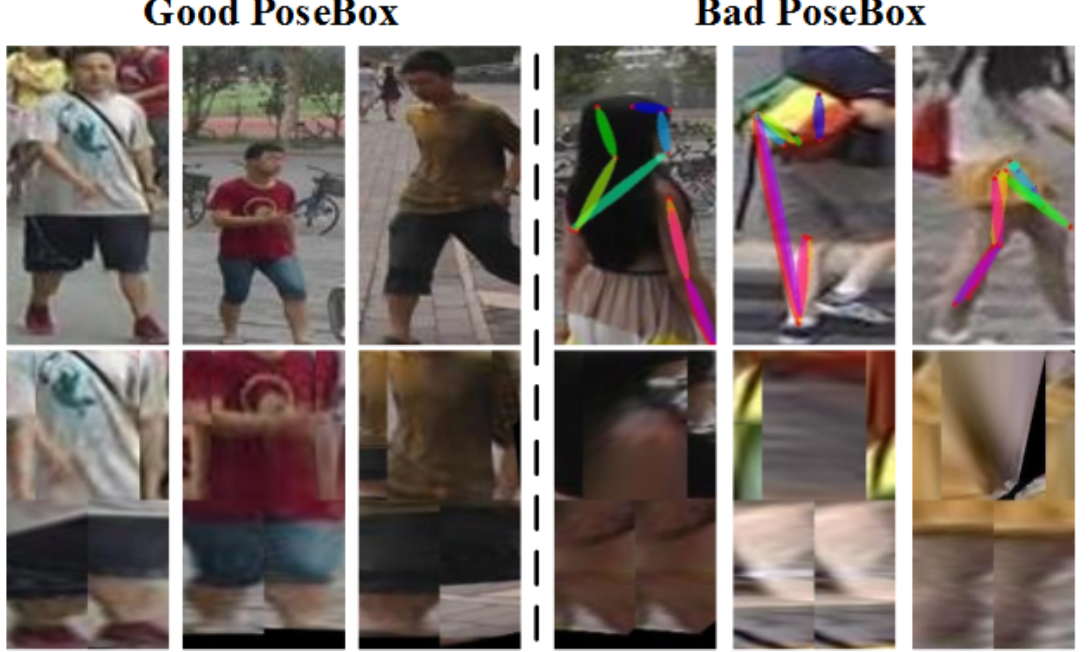
Figure 2. Examples of good and bad PoseBox constructed by PIE: (Top row) original bounding boxes with detection errors/occlusions; and (Bottom Row) corresponding